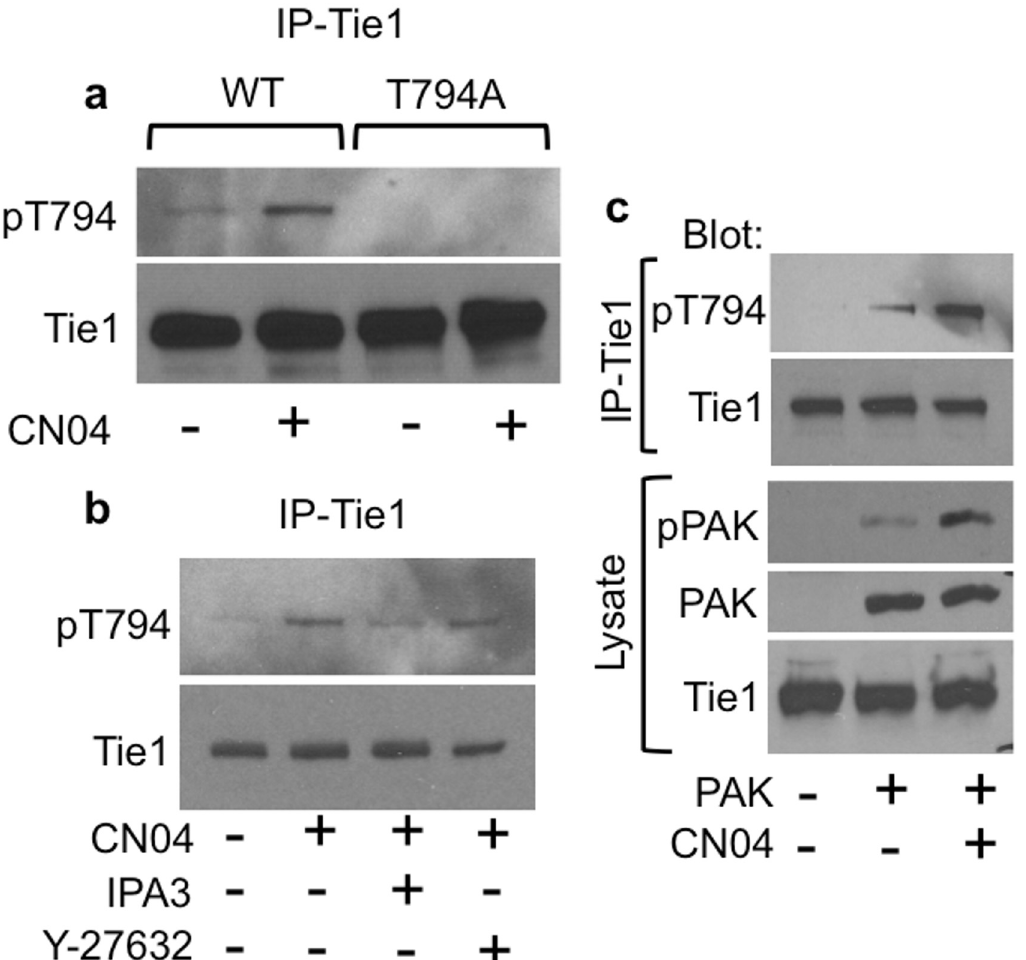
Fig 5. Rac1-mediated PAK1 activation results in Tie1-T794 phosphorylation. a Rac1 was activated using CN04 in HUVECs infected with AdTie1 WT or T794A. Tie1 was immunoprecipitated (IP) and western blotted as indicated. CN04-mediated Rac1 activation resulted in T794 phosphorylation which was ablated by the T794A mutant. b CN04-mediated T794 phosphorylation was reduced by PAK1 inhibition (IPA3, 10 μ M) but not ROCK1 inhibition (Y – 27632, 10 μ M). c HEK-293T cells transfected with Tie1-WT alone or together with PAK1 were treated with or without CN04, and Tie1 IPs and whole cell lysates were western blotted as indicated. Co-expression of PAK1 induced Tie1-T794 phosphorylation, which was augmented by CN04-mediated activation of Rac1 and